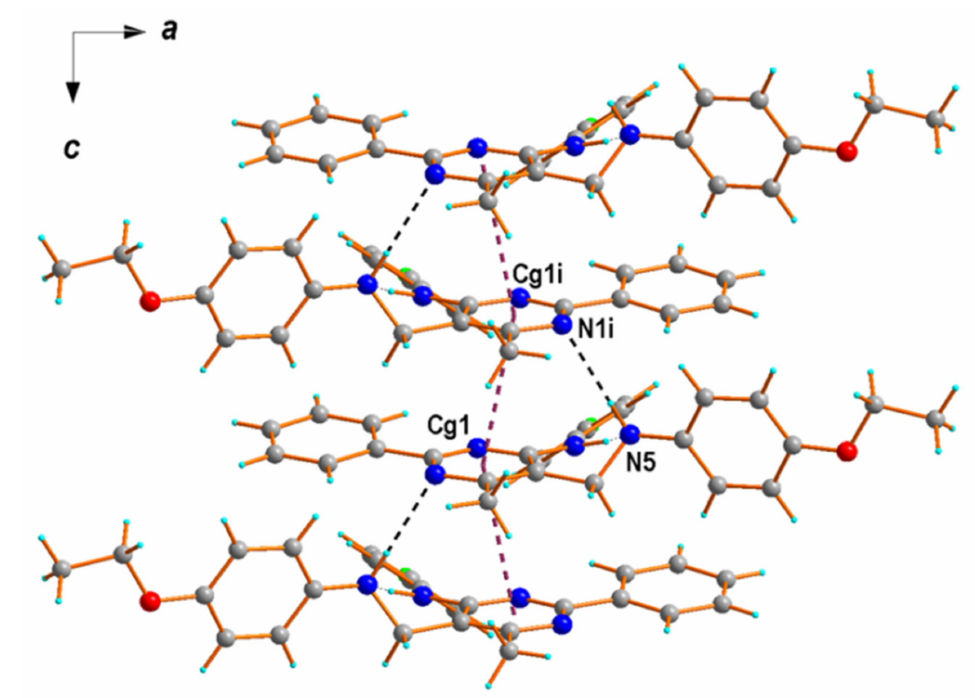
Figure 3. Part of the crystal structure of 2 , showing the formation of the one-dimensional chain through intermolecular interactions with N–H · · · N (in black) and π - π (in plum). Cg1 is the centroid of the N1–C6 ring. Symmetry code is the same as in Table